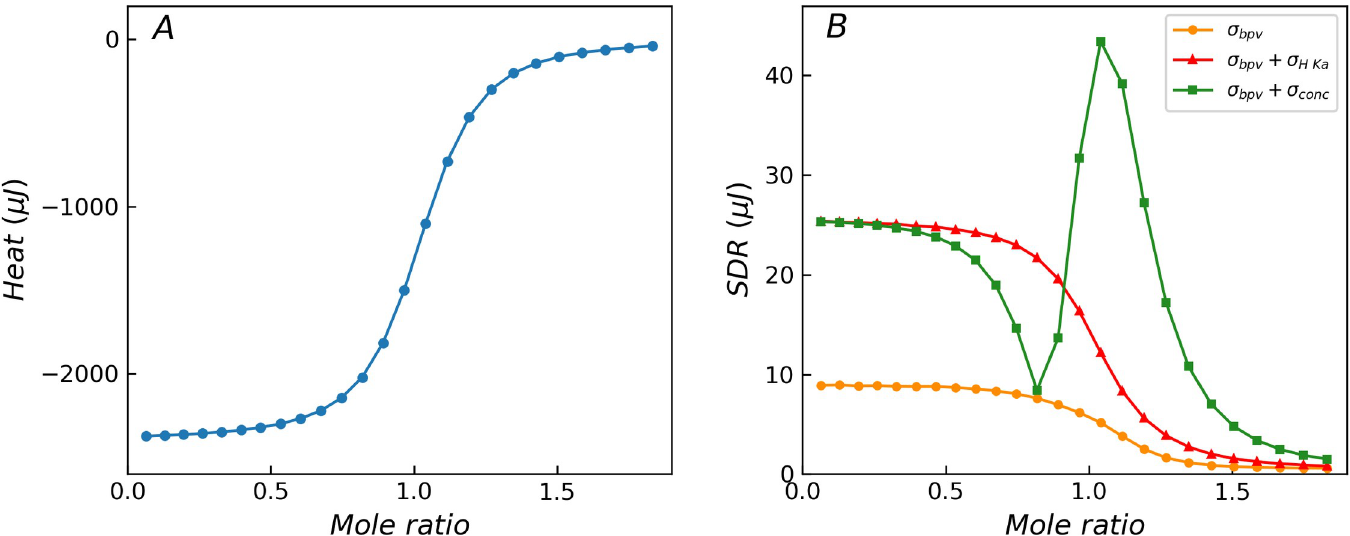
Fig 4. Theoretical titration curves without error components (A) and distribution of SDR for reactions with different error components (B). The orange curve is the control curve with three basic error components ( σ bpv ), the red curve has additional error components ( σ H Ka ) in reaction parameters K a and Δ H , and the green curve has additional error component ( σ ) in titrant concentration. The additional error components obviously change the distribution characteristics of the heat residual, conc resulting in a significant deviation from the prediction result of the variance function.